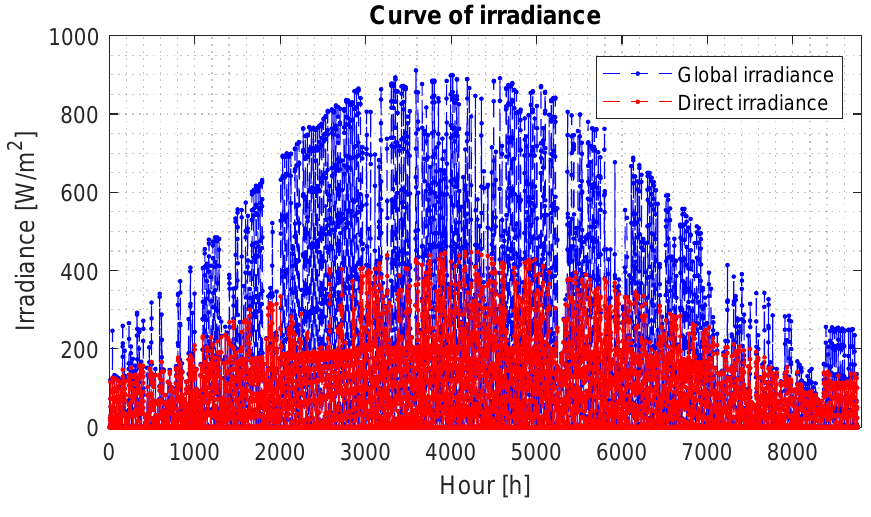
Figure 11. Irradiance